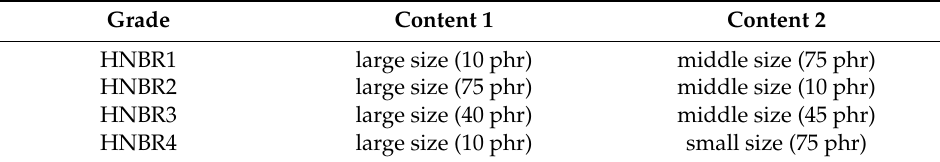
Table 1. The model hydrogenated nitrile butadiene rubber (HNBR) grades and their CB contents.